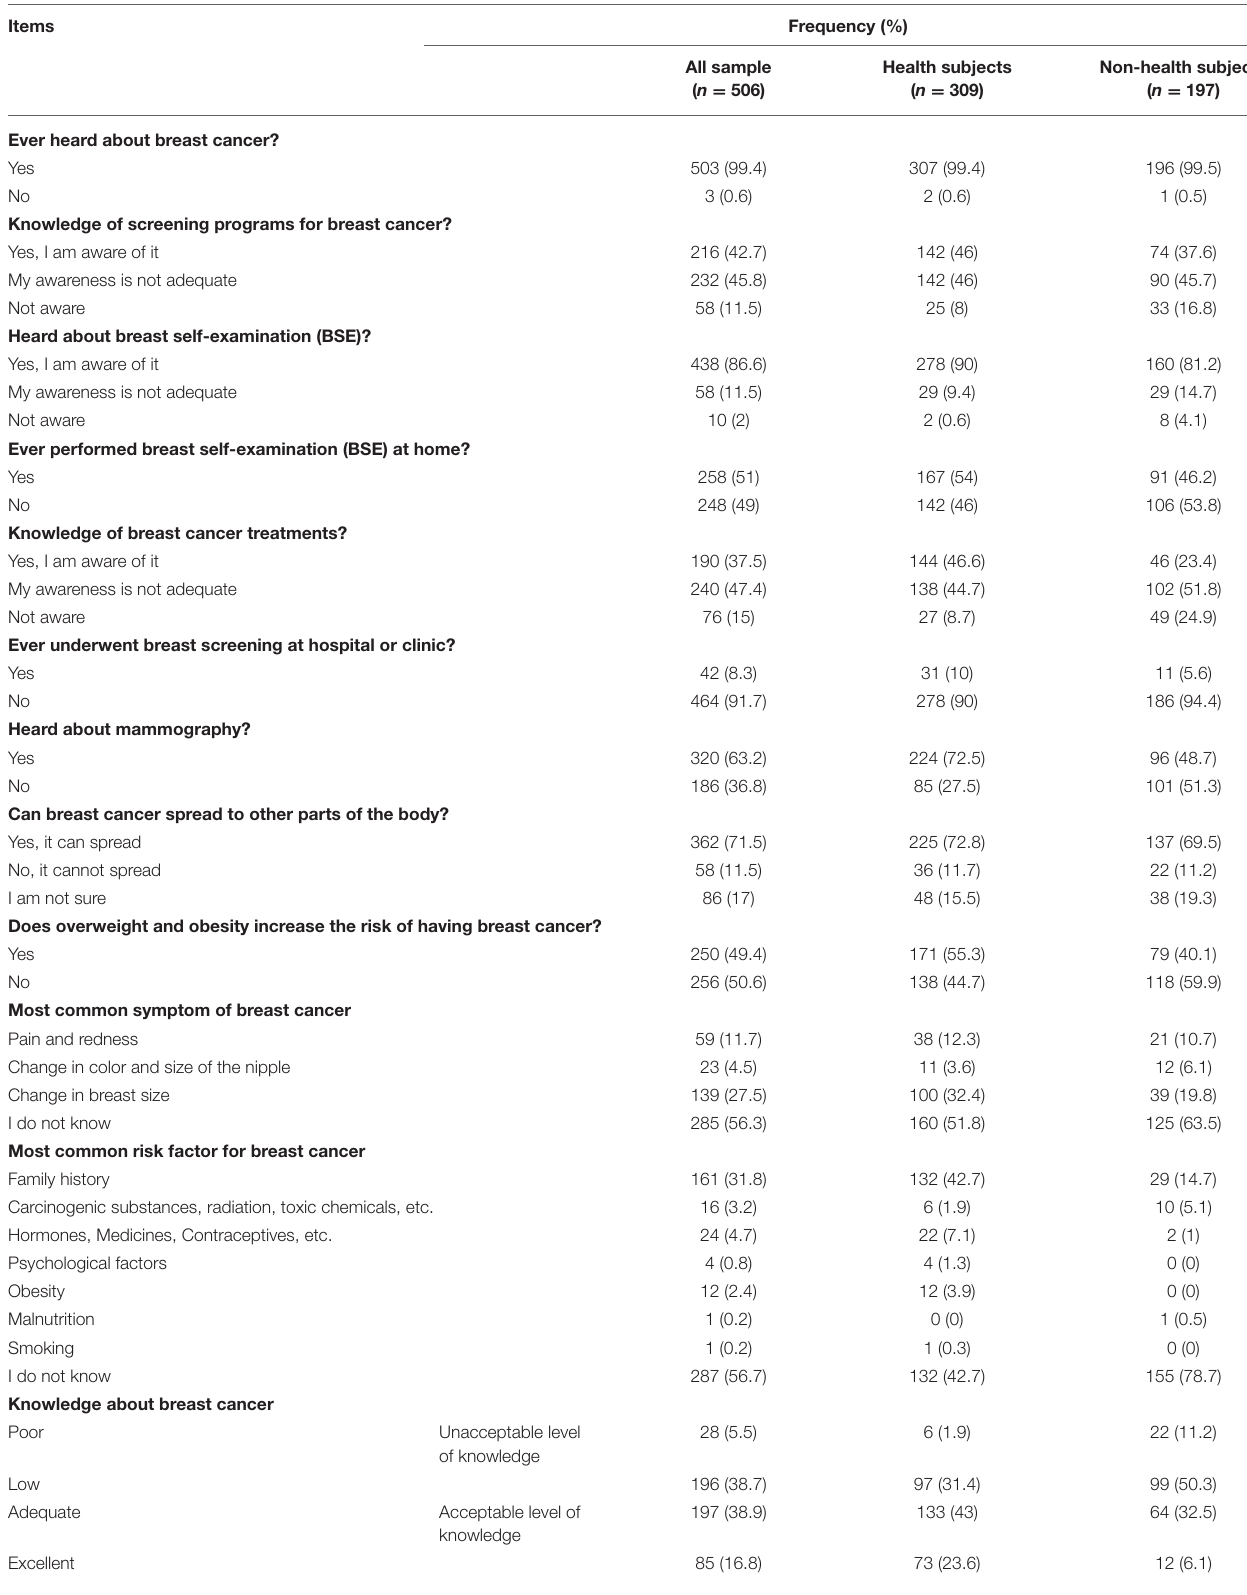
TABLE 4 | Knowledge of BC ( N =